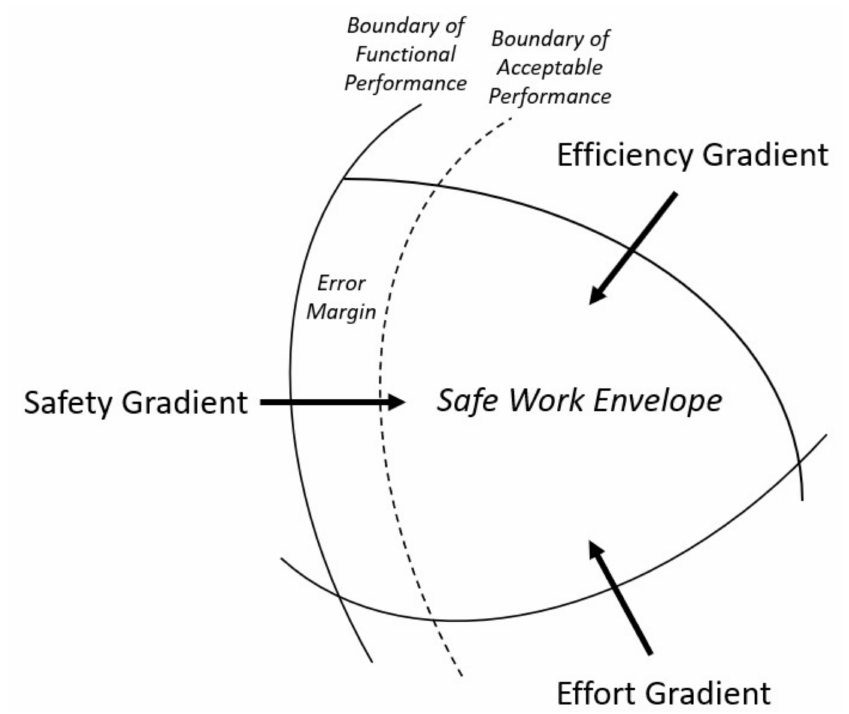
Figure 1. Rasmussen’s dynamic risk modeling framework. Reproduced from Rasumussen